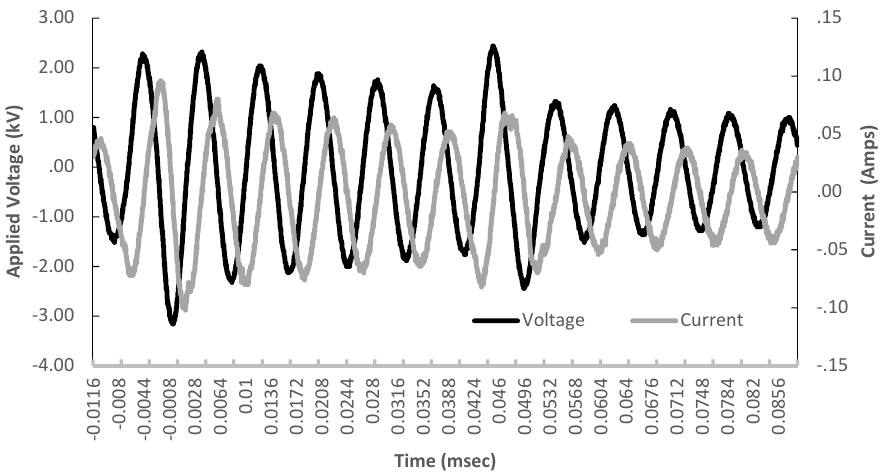
Figure 3. Typical voltage and current traces collected from the plasma deposition device without collagen aerosol.